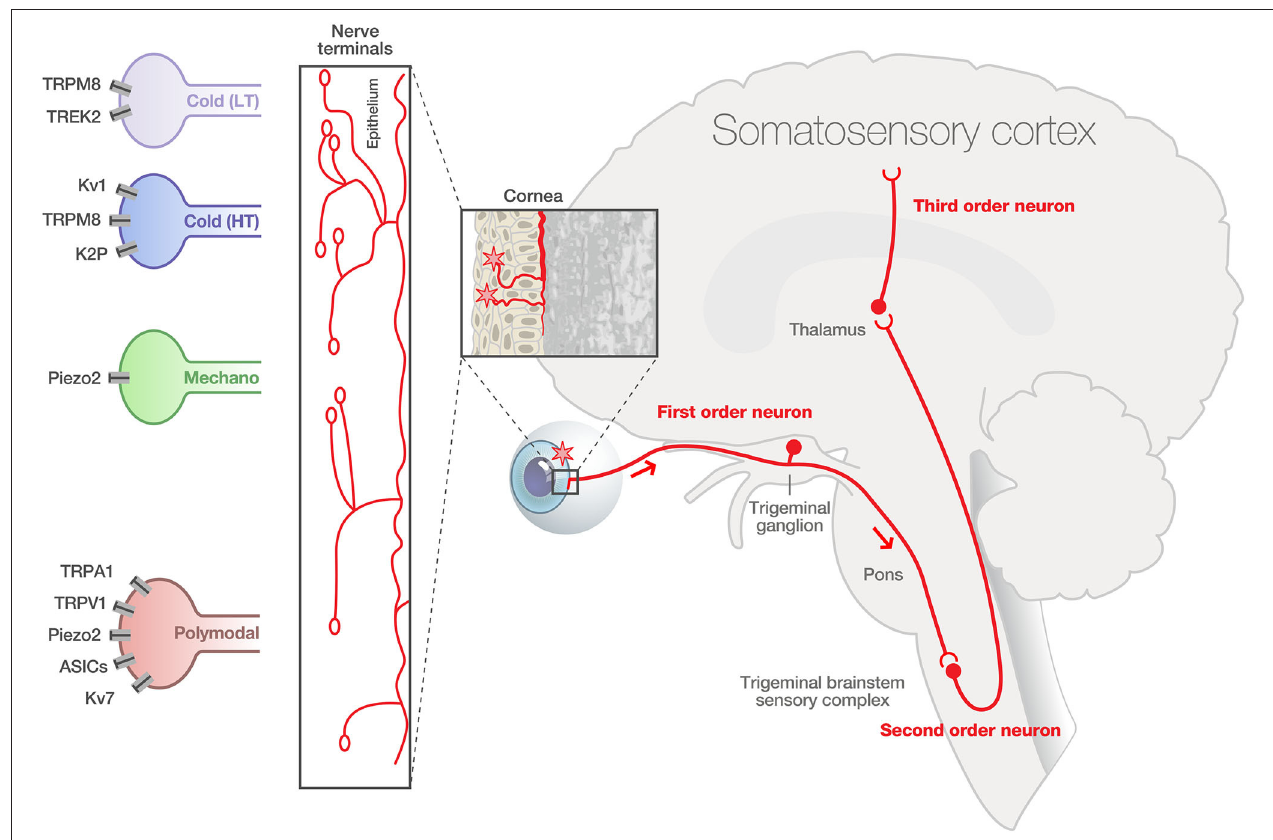
FIGURE 1 | Physiological corneal pain processing. The cornea contained a high density and heterogeneity of A delta and C fibers expressing specialized transient receptor channels, able to respond to diverse environmental stimuli of varying intensities (cold, mechanical, and polymodal). The intraepithelial nerve fibers exhibit distinct morphologies: complex, ramified, and simple. First order sensory neurons innervating the cornea have their cell body in the ophthalmic branch (V1) of the trigeminal ganglion (TG). The central terminals of these pseudo unipolar neurons synapse in the trigeminal brainstem sensory complex with second order nociceptive projection neurons. These neurons project to the thalamus and synapse with third-order neurons projecting to cortical regions (primary somatosensory cortex). LT, low-threshold cold thermoreceptors; HT, high-threshold cold thermoreceptors. Modified from Belmonte et al. (2015) and Rosenthal and Borsook (2016).